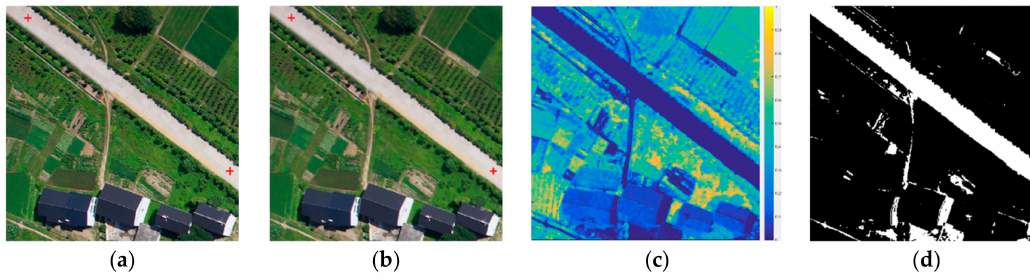
Figure 1. Flowchart of the proposed ECFM method.We use a real example to illustrate the detailed flow of the presented method. The example is shown in Figure 2. A detailed description of the method is provided in the following